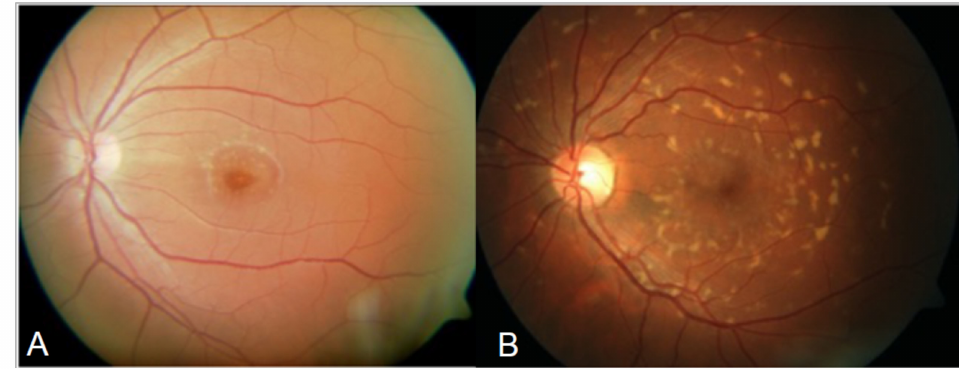
Figure 1. Colour fundus photographs: ( A ) foveal atrophy surrounded by a minimal amount of flecks; and ( B ) widespread flecks that would be consistent with a fundus flavimaculatus